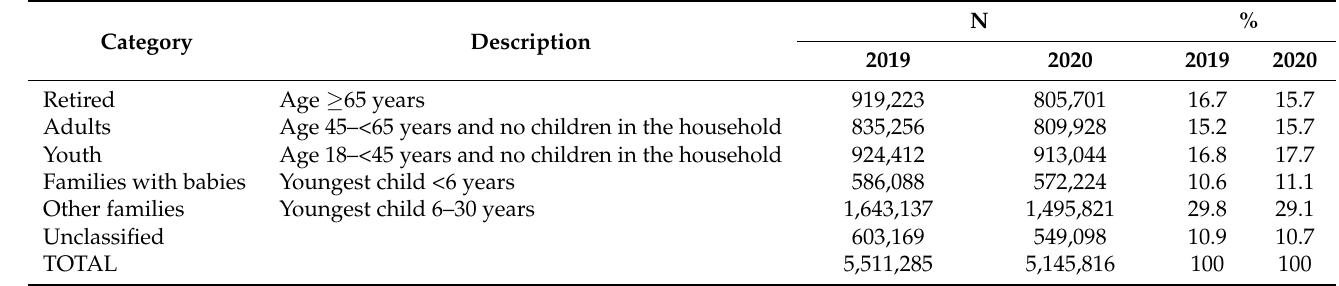
Table 1. Classification of loyalty card